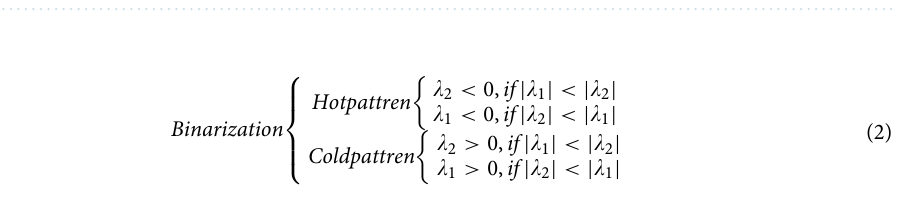
Figure 16. Shape context descriptors ( a ) for W points, ( b ) for B points, and ( c ) for C points. Feature point